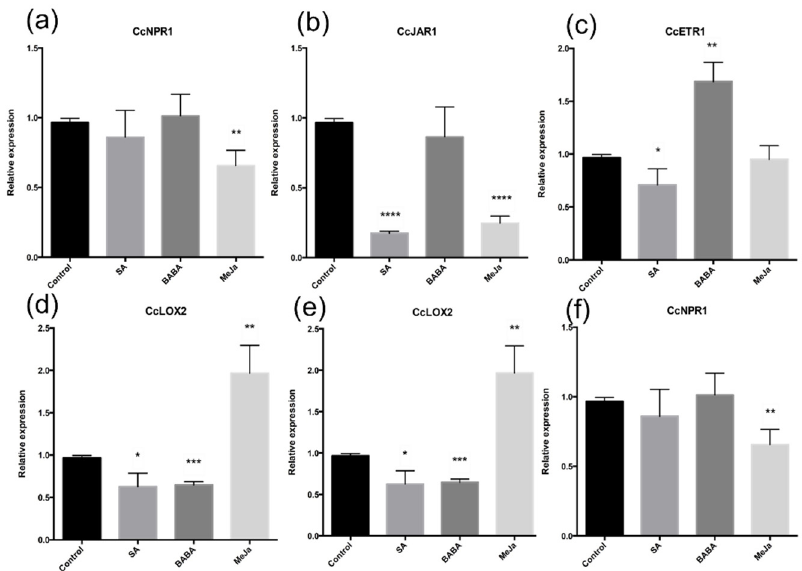
Figure 3. Effects of elicitors treatment on Capsicum chinense plants in genes stress-responsive. Quan- titative RT PCR determinations of relative expression levels of the genes: CcNPR1 ( a ), CcJAR1 ( b ), CcETR1 ( c ), CcLOX2 ( d ), CcPR4 ( e ), and CcPDF1 ( f ). The data represented means of triplicate bio- logical and experimental repeats; error bars represented SEM. The asterisk indicates statistically significant differences between treatments (range test p < 0.05).